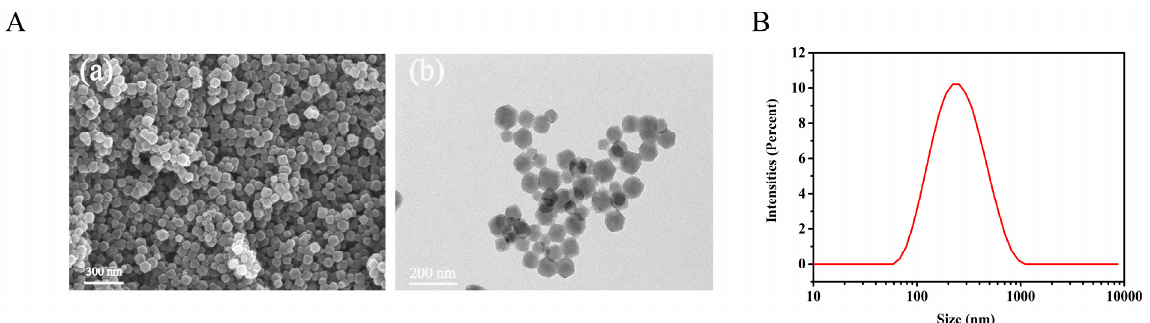
Figure 1. ( A ) SEM image ( a ) and TEM image ( b ) of DHM@ZIF-8. ( B ) Particle size distribution of DHM@ZIF-8.